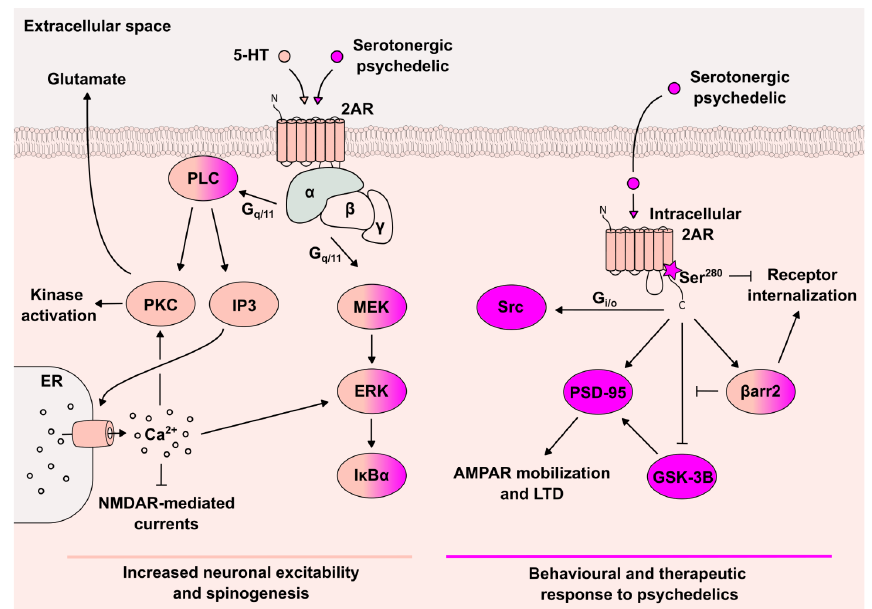
Figure 2. Canonical and psychedelic-related 2AR signaling pathways in neurons. Stimulation of 2AR by 5-HT (canonical agonist) results in the activation of G q/11 protein and the consequent activation of the PLC and MEK pathway (left). Together, these signaling pathways result in increased neuronal excitability and spinogenesis at the postsynaptic membrane. Stimulation of 2AR by serotonergic psychedelics regulate additional signaling pathways, including G i/o -mediated Src activation as well as G protein-independent pathways mediated by proteins such as PSD-95, GSK-3B and β arr2 (right). These signaling pathways, in addition to a biased phosphorylation of 2AR at Ser280, were demon- strated to be involved in mediating the behavioral response to psychedelics and are likely attributed to intracellular 2AR activation. Psychedelic-specific signaling is indicated in pink, while non-specific signaling is indicated in beige. AMPAR: α -amino-3-hydroxy-5-methyl-4-isoxazolepropionic acid receptor, β arr2: β -arrestin-2, ER: Endoplasmic Reticulum, ERK: Extracellular signal-regulated kinases, GSK-3B: Glycogen synthase kinase-3 beta, I κ B α : Nuclear Factor of Kappa Light Polypeptide Gene Enhancer in B-cells Inhibitor, Alpha, IP3: Inositol Trisphosphate, NMDAR: N-methyl-D-aspartate receptor, PKB: Protein kinase B, PKC: Protein kinase C, PSD-95: Postsynaptic density protein 95, 5-HT: Serotonin and Src: Proto-oncogene tyrosine–protein Kinase